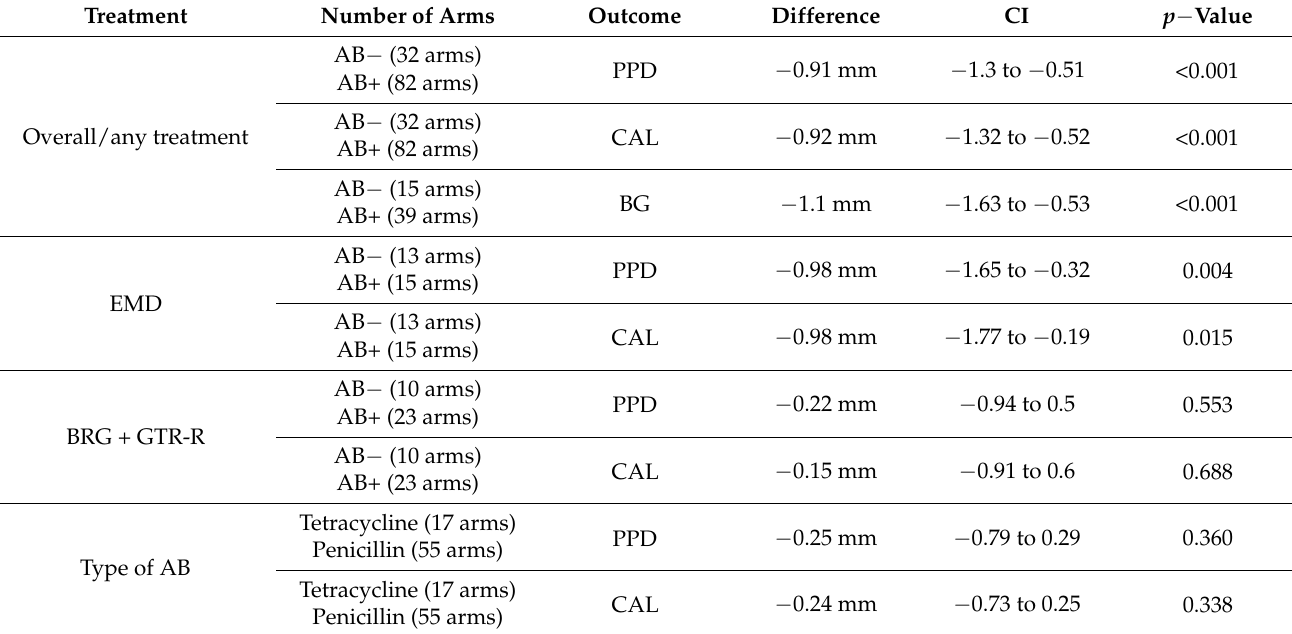
Table 3. Summary of meta-regressions for studies on